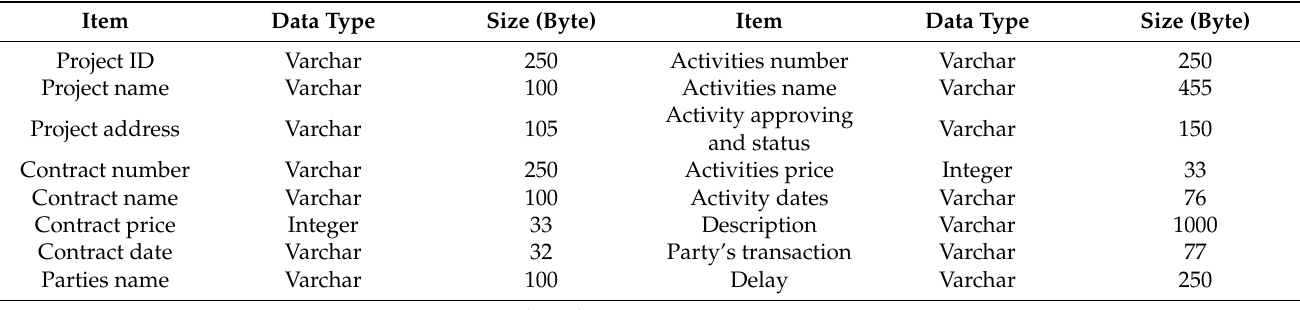
Table 5. Storage size of different transactions for full block.